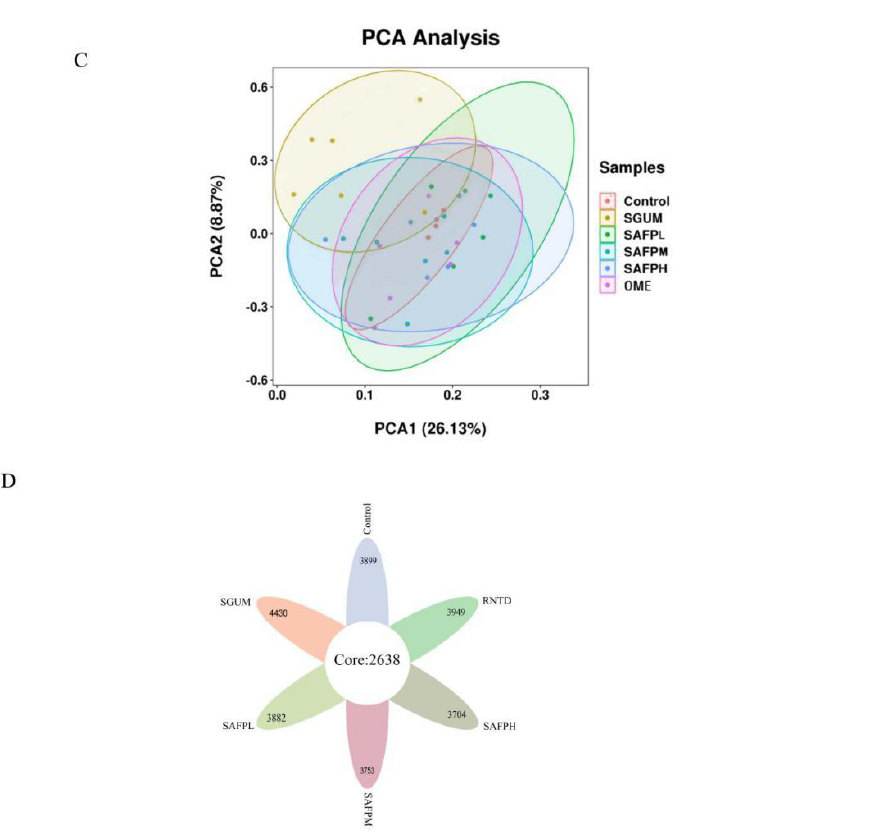
Figure 7. Effects of SAFP on the richness and diversity of caecal microbiota ( n = 5). ( A ) Shannon index curve and rank abundance curve. ( B ) Operational taxonomic unit (OTU) richness and diversity indices. ( C ) Principal coordinate analysis score plot of gut microbiota. ( D ) Petal diagram presenting the OTUs between different groups. SAFPL group represents SAFP low-dose group (100 mg/kg BW); SAFPM group represents SAFP middle-dose group (200 mg/kg BW); SAFPH group represents SAFP high-dose group (400 mg/kg BW).